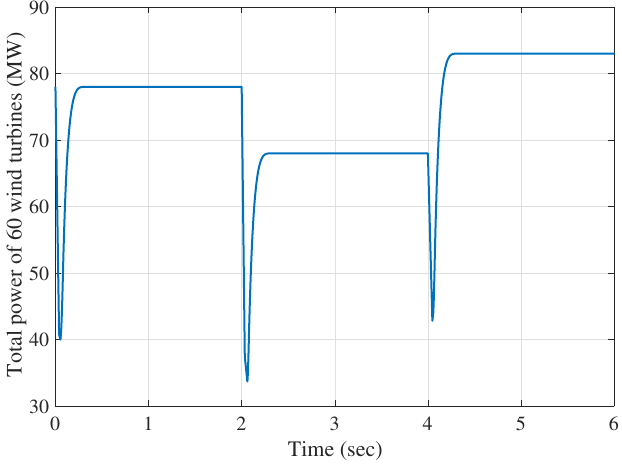
Figure 3. Variation curve of total power of 60 wind turbines in Princess Amalia wind farm.